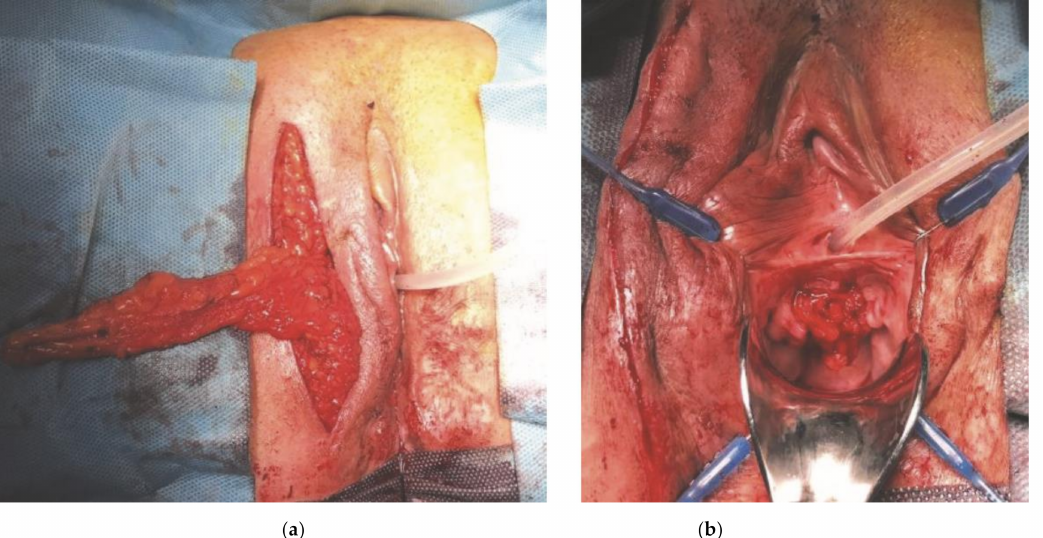
Figure 2. Martius flap interposition ( a ) Prelevation of the Martius flap—( b ) After transposition of the Martius flap to the ventrally reconstructed